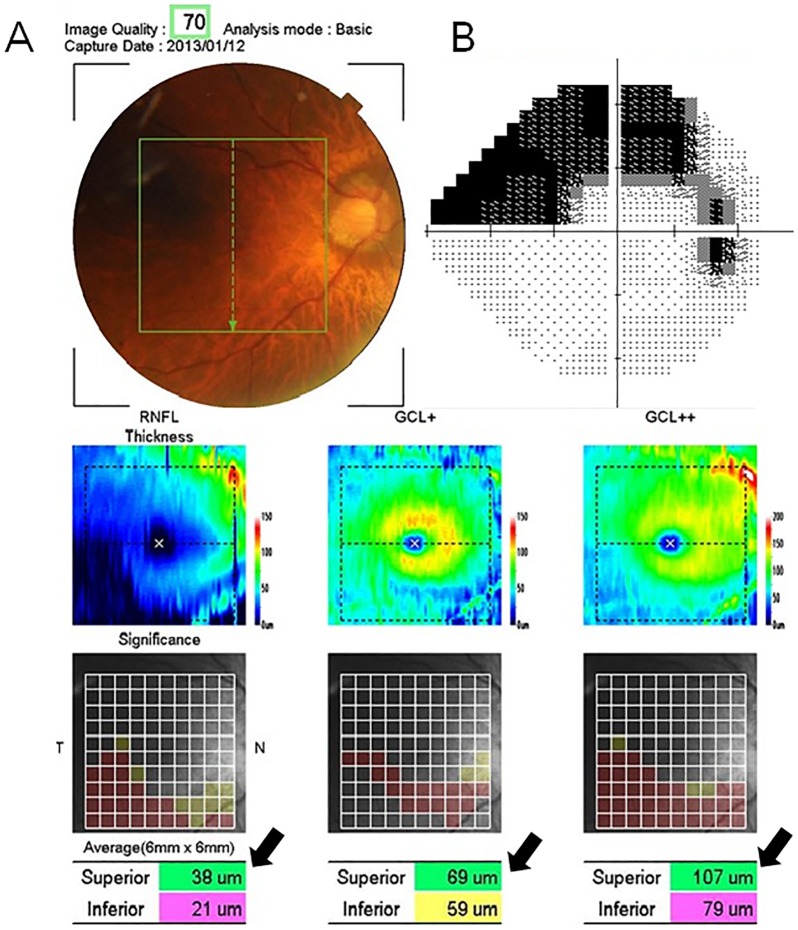
The 3D-OCT map and results of the HFA test in a 71-year-old male subject with glaucoma.(A) The 3D-OCT map provides a 10×10 grid map of the macular RNFL (GCL+), ganglion cell layer (GCL)/inner plexiform layer (IPL) thickness (GCL++) and macular RNFL+GCL+IPL. Upper panel: a pseudo-colored map of the measured thickness. Center panel: Each grid in the 10×10 grid was color-coded, with no color (within the normal limit), yellow (outside of the 95% normal limit) or red (outside of the 99% normal limit) used to indicate different values. Lower panel: the thicknesses of the total, superior and inferior hemiretinal sectors. The black arrows show the superior hemiretinal thickness, which is displayed as color-coded with green (within the normal limit), yellow (outside of the 95% normal limit) or red (outside of the 99% normal limit) based on the software program's normal built-in dataset. (B) The results of the HFA test. The MD was −9.38 dB (P<0.5%) and the PSD was 14.54 dB (P<0.5%). Superior glaucoma visual field damage corresponds to inferior optic disc rim thinning and the 3D-OCT data. The inferior visual field was intact.